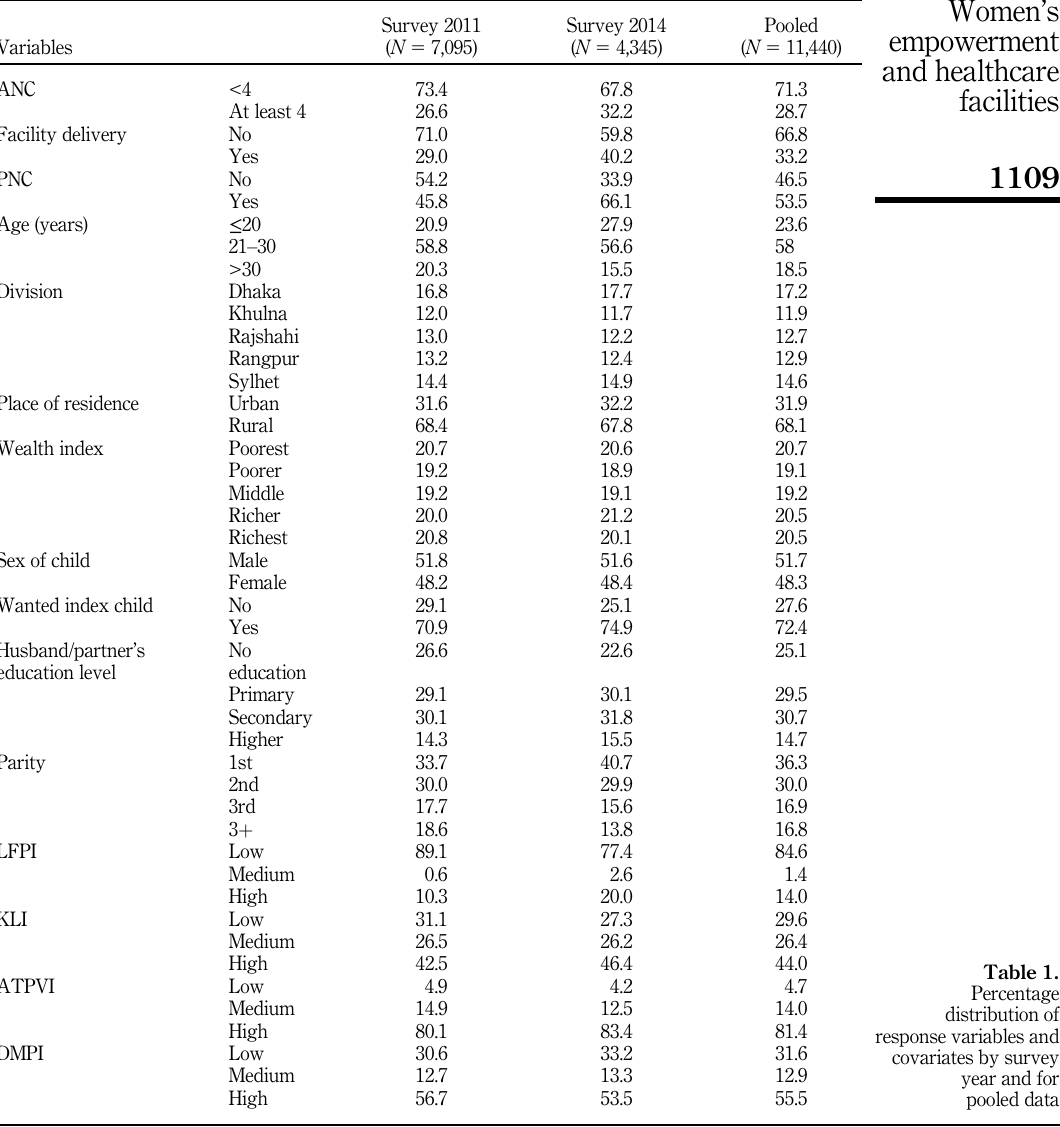
Table 3 suggested a three-level model was appropriate for analyzing these data as all the random effect parameters were significantly greater than zero and all ICC values were greater than zero. The regression results showed the practice of all three considered healthcare facilities significantly increased in 2014 compared to 2011. Mothers with high and medium KLI were 2.14 and 1.56 times more likely to have at least four ANC visits compared to mothers with low KLI. Mothers with high ATPVI and DMPI also had a higher chance of having at